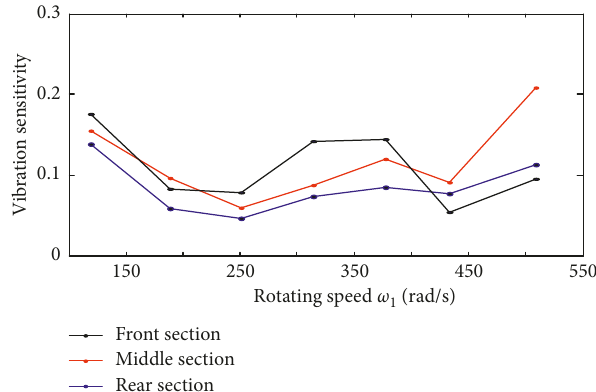
Figure 24: Experimental vibration sensitivity S with varying ro- tating speed of low-pressure rotor ω l : front section (black), middle section (red), and rear section (blue).